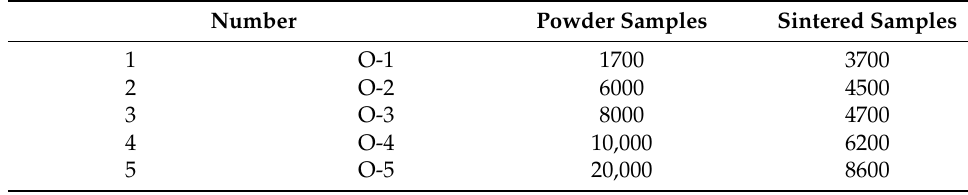
Table 2. O content in preparation of Mo specimens (ppm by weight,